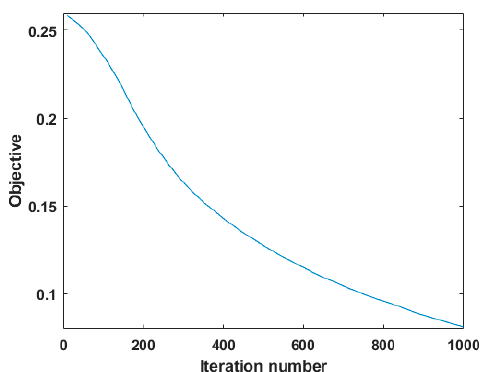
Figure 9. Illustration of convergence of the optimization.